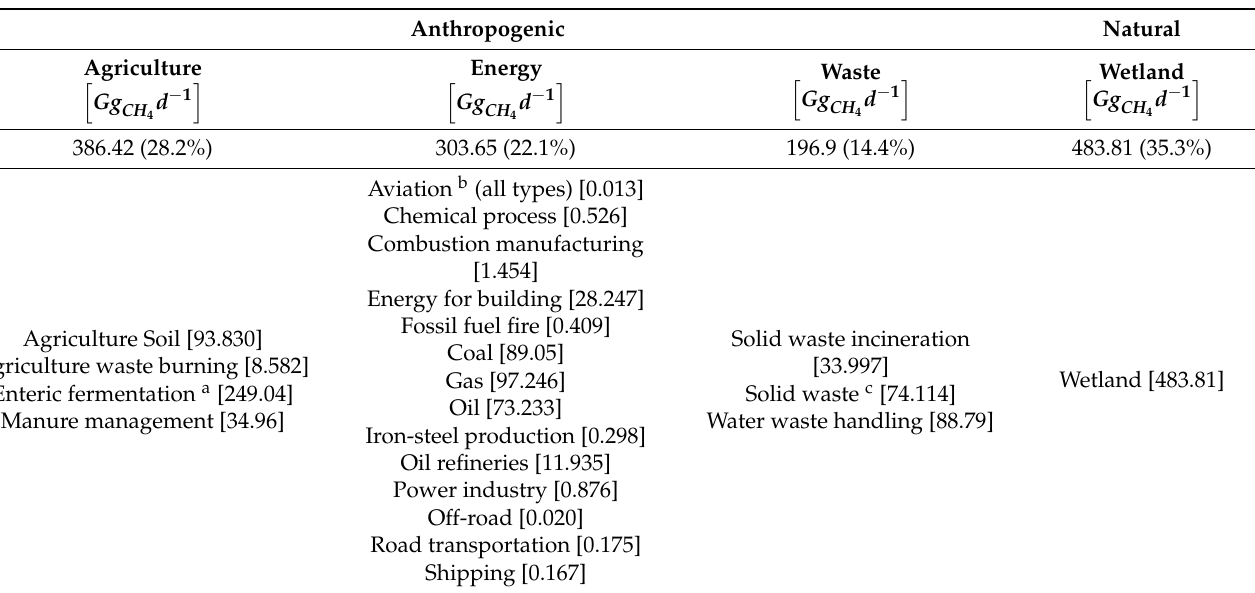
Table 1. Total daily mean methane emissions in four main sectors and their subsets. Anthropogenic emissions are based on EDGAR v6, and natural emissions are obtained from WetCHARTs v3.0 with the full ensemble